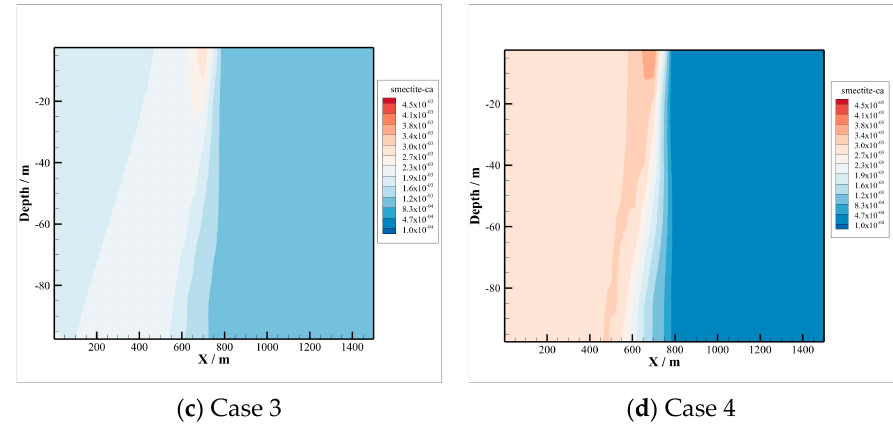
Figure 18. Smectite-Ca precipitation in different cases.